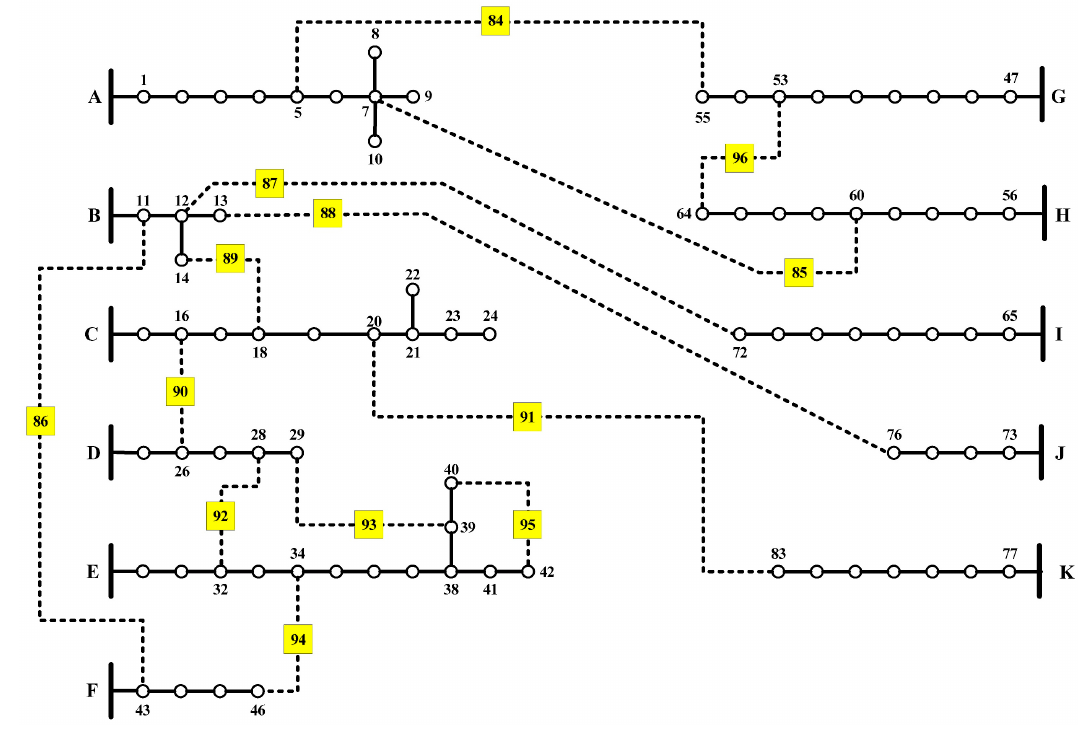
Figure 7. The 83-node distribution system.